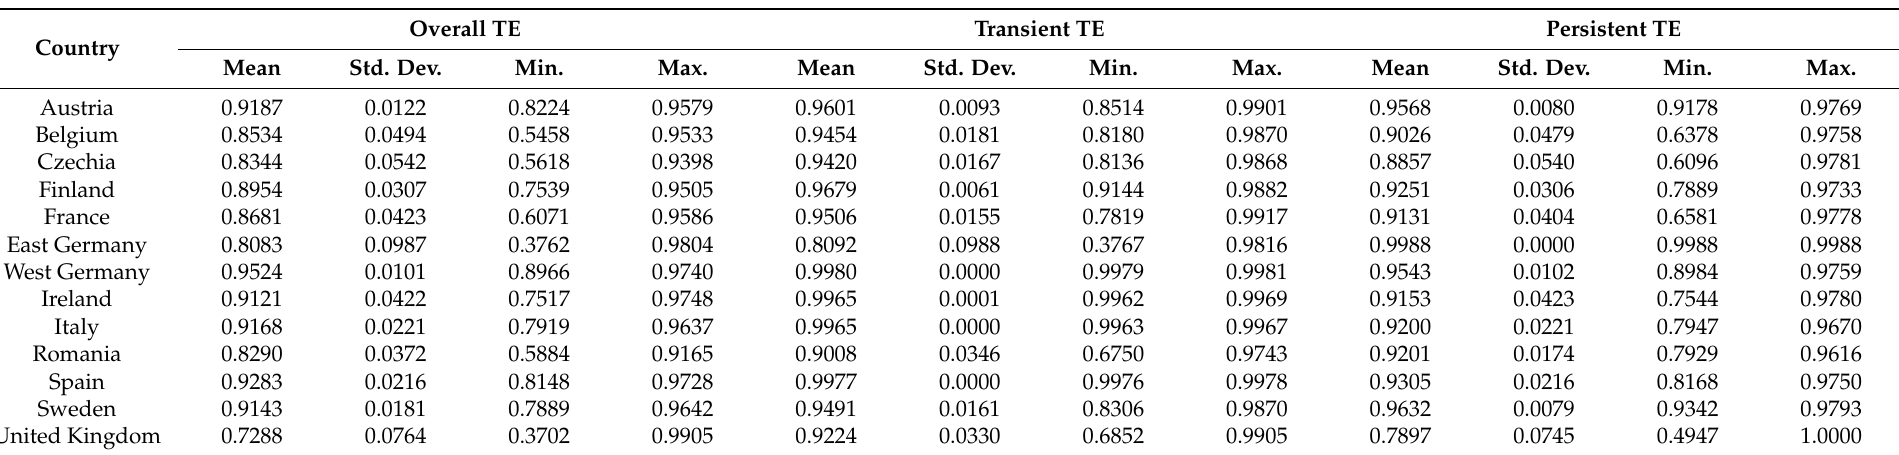
Table 4. Overall technical efficiency and its decomposition. Source: authors’ own